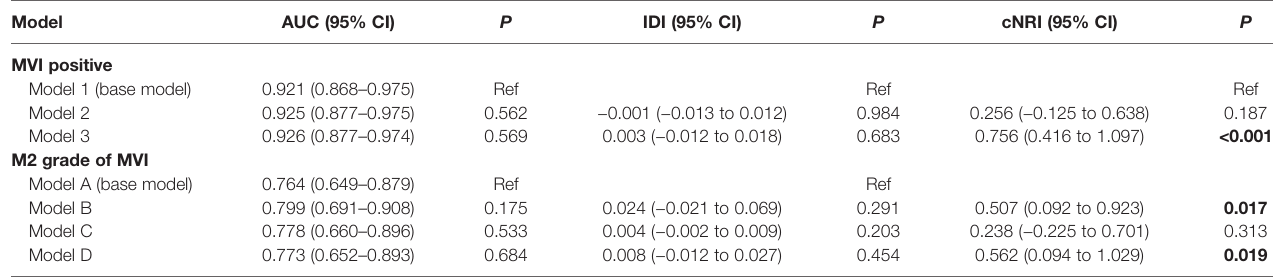
TABLE 4 | Comparison of different prediction models for estimating the risk of MVI and its M2 grade. Model